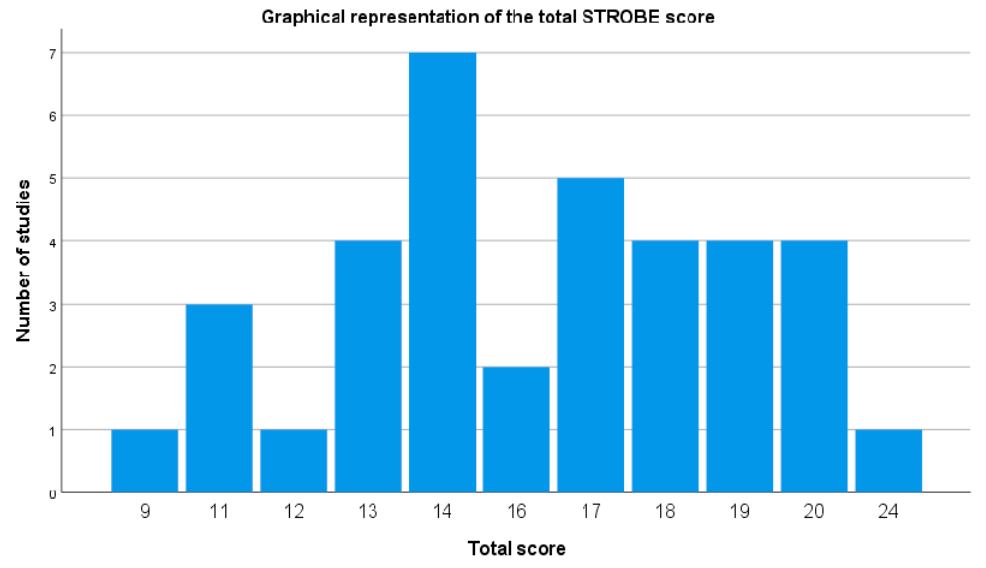
Figure 2. Graphical representation of the total STROBE score.